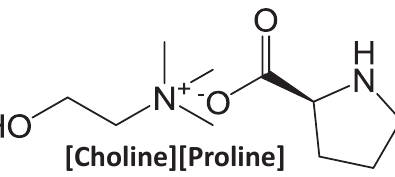
Figure 1. Molecular structure of [Choline] [Proline] ionic